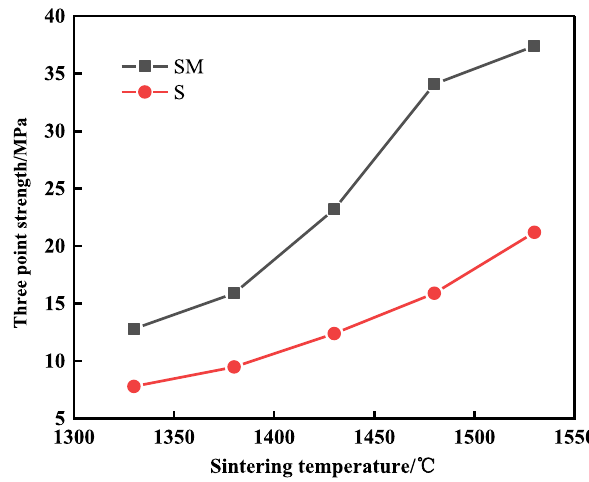
Fig. 10 Three-point flexural strength of the samples sintered at differ- ent sintering